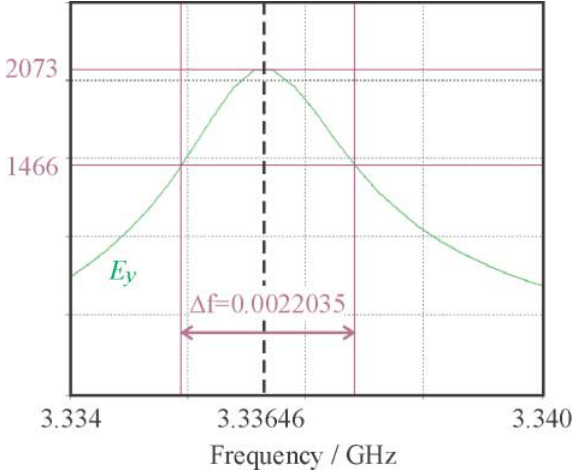
FIG. 6. (Color) Zoomed spectrum of the E y component around its peak at f (cid:1) 3.336 45 GHz showing a 3 db bandwidth of D f (cid:1) 0.0022 GHz and thus a quality factor of Q RAD (cid:1) 1514